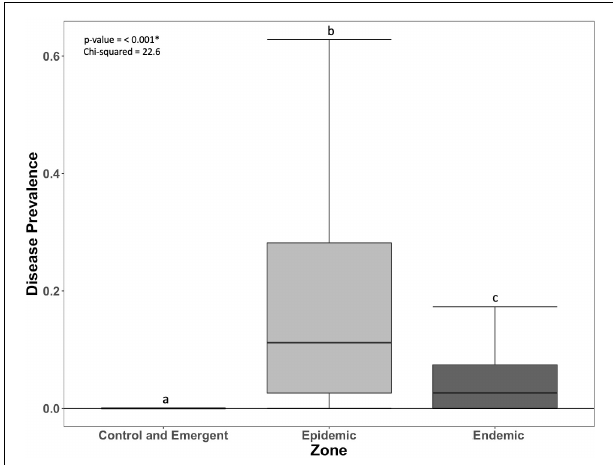
FIGURE 2 | Prevalence of acute tissue loss (ATL) on coral reefs in each zone ( ± SEM). Letters indicate significant differences among zones.